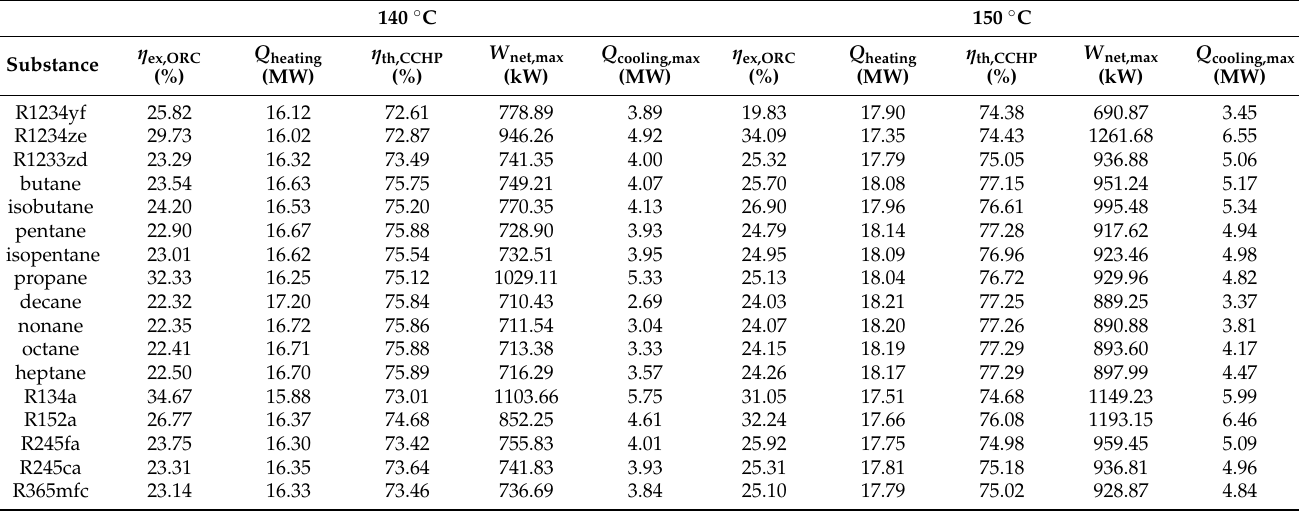
Table 7. Performance comparison of working fluids at temperature of geothermal fluid is 140 and 150 ◦